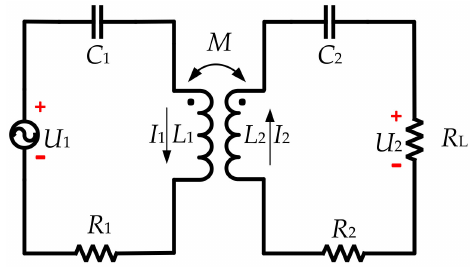
Figure 2. Simplified model of the SS-WPT